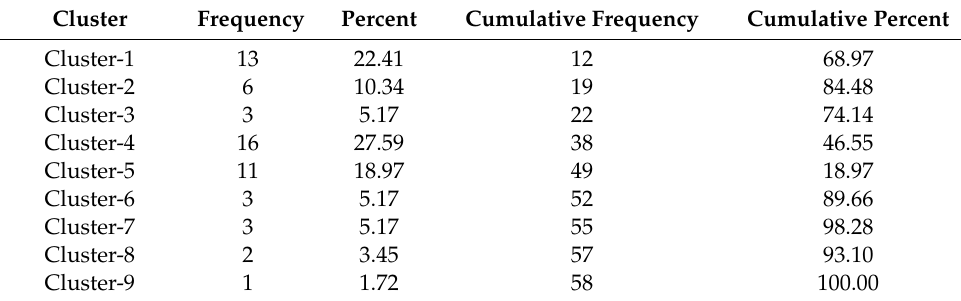
Table 4. Frequency of Banks in Each Cluster.